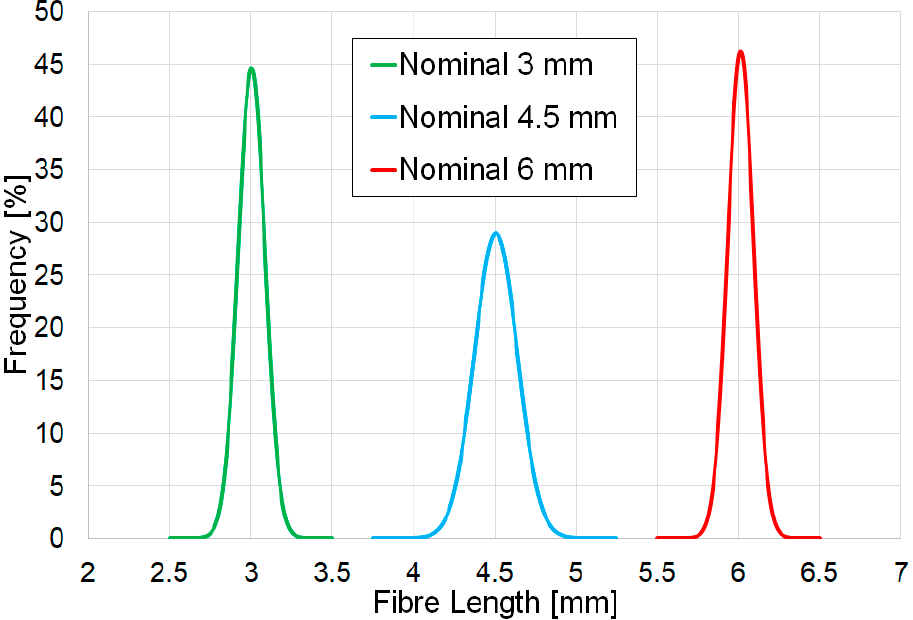
Figure 3. Fibre length distribution